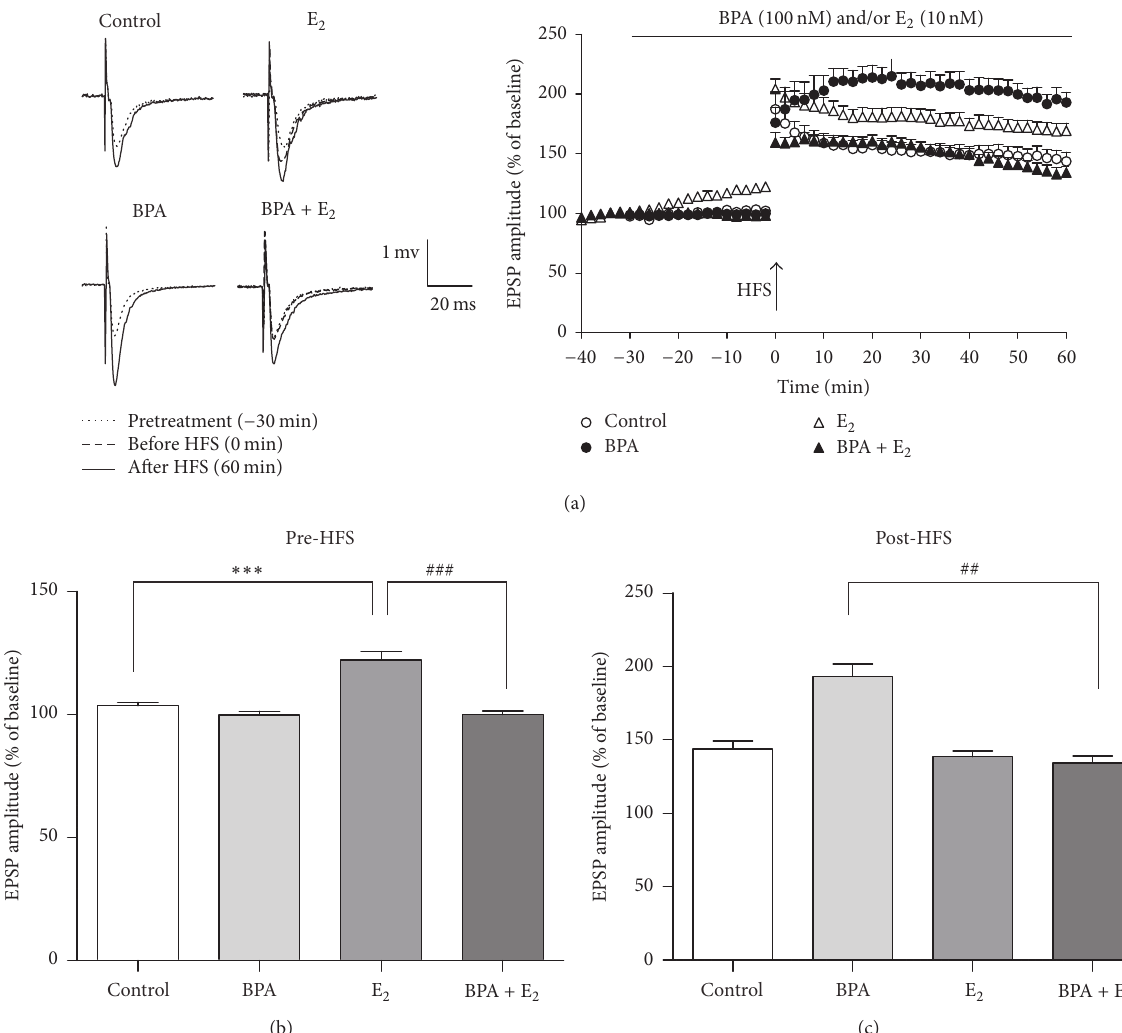
Figure 4: The enhancement of BPA on hippocampal LTP was abolished by E 2 treatment. Enhanced LTP by E 2 (10nM) in hippocampal area DG (open triangles, 𝑛 = 8 ). Coadministration of BPA 100 nM with E 2 (filled triangles, 𝑛 = 8 ) had no effect on LTP compared with untreated controls. (b) Pretreatment by E 2 enhanced the pre-HFS EPSP amplitudes, ∗∗∗ 𝑝 < 0.001 as compared to controls, ### 𝑝 < 0.001 as compared to the E 2 10nM. (c) Comparison of different groups the fEPSP amplitudes at 60min. E 2 had no effect on LTP compared with untreated controls without baseline increase in EPSP amplitude (before the HFS). ∗∗∗ 𝑝 < 0.001 as compared to the control, ## 𝑝 < 0.01 as compared to the BPA 100nM. Solid and dashed traces are examples of before treatment, after treatment, and after HFS, respectively.